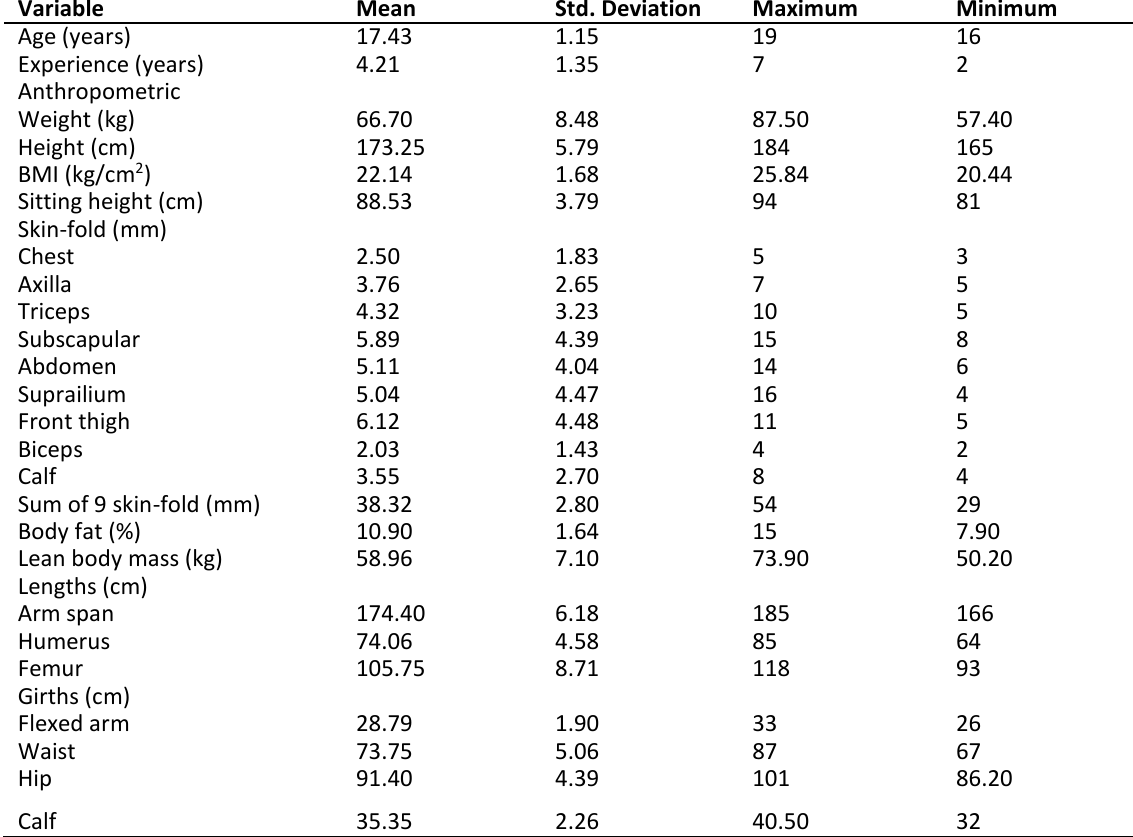
Table 1. Anthropometric and body composition characteristics of young elite